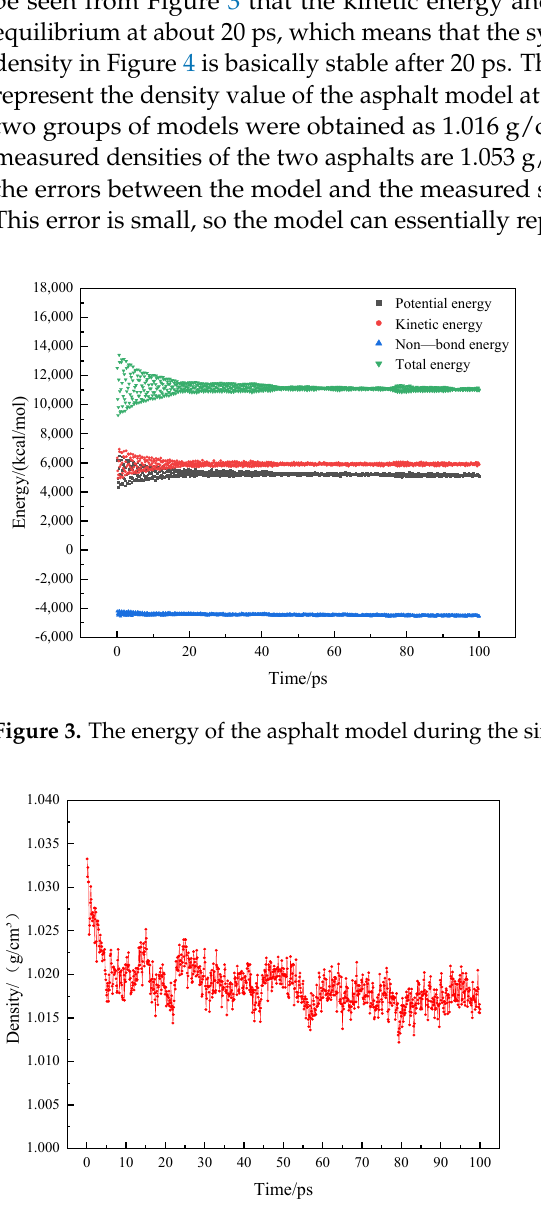
In the formula: SP is the solubility parameter; E is the cohesive energy; V is the vol- ume; and E/V is the cohesive energy density. ume; and E/V is the cohesive energy density.